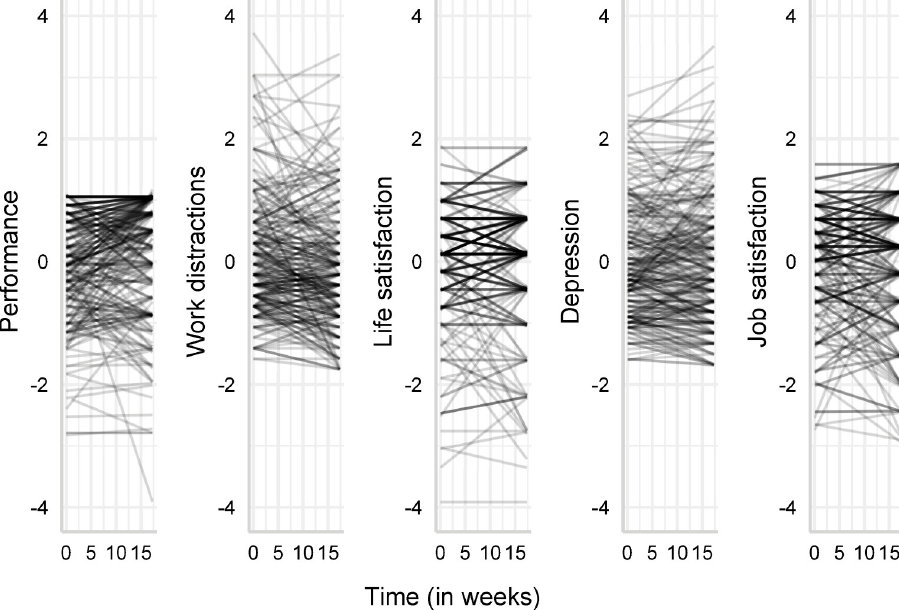
Fig 1. Between-individual heterogeneity in temporal development in worker outcomes. Each line represents a slope of time computed for each individual. Outcomes are z-transformed.